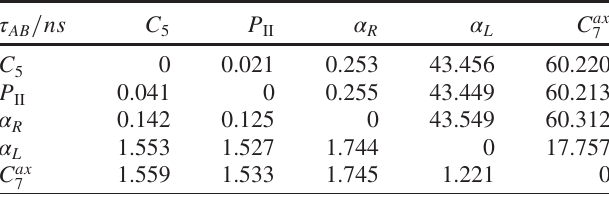
TABLE I. Mean first-passage time (MFPT) between metastable regions of alanine dipeptide. The MFPTs have been estimated from 10 μ s of simulation data using a Markov state